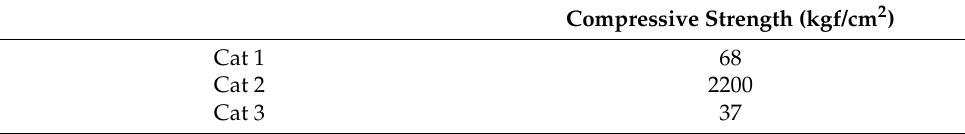
Table 3. Compressive strength of the catalysts.